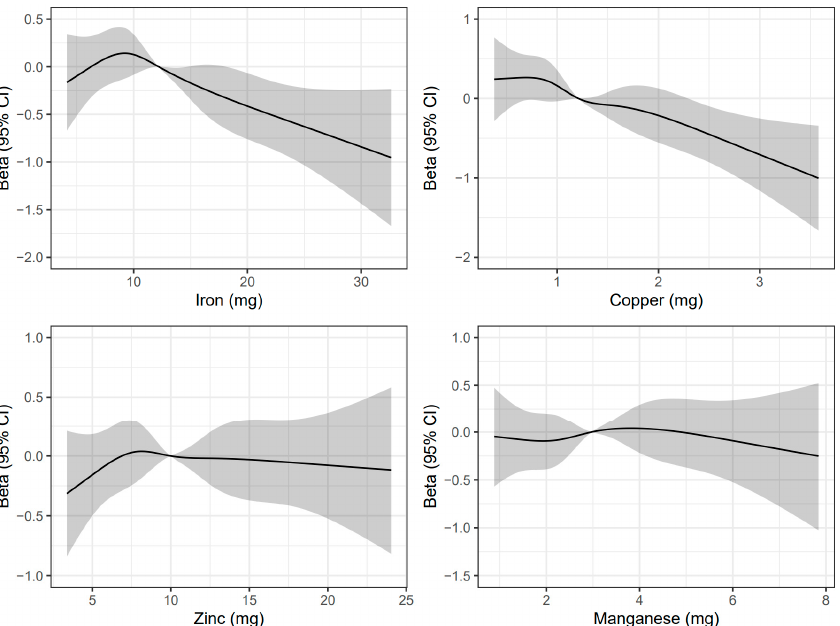
Figure 1. Restricted cubic splines for the association of dietary intake levels of iron, copper, zinc, and manganese with global cognitive score. The reference point was set as the median values of dietary intake levels of iron, copper, zinc, and manganese. P-nonlinear = 0.209 for dietary iron intake, 0.836 for dietary copper intake, 0.613 for dietary zinc intake, and 0.704 for dietary manganese intake. The solid line represents the beta of the linear model, and the shaded area represents the 95% CIs of beta.